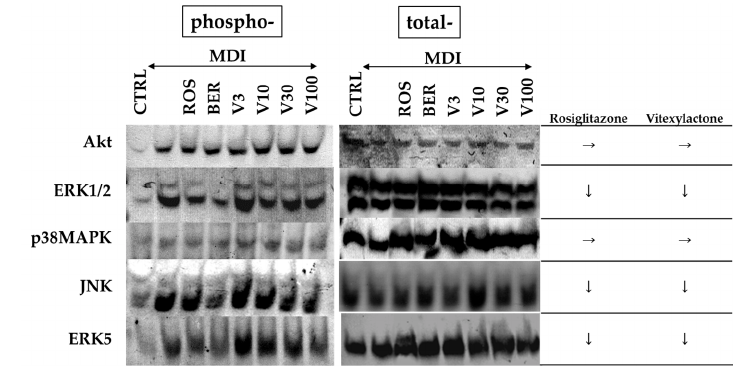
Figure 6. The effects of each compound on the phosphorylation of signal transduction-related kinases in 3T3-L1 cells 30 min after the addition of each compound. Protein levels were measured by electroblotting. Undifferentiated cells, cells with the addition of MDI (a mixture of 0.5 mM 3-isobutyl-1-methylxanthine (M), 0.1 μ M dexamethasone (D), and 2 μ M insulin (I)), rosiglitazone, berberine, and vitexilactone are indicated by CTRL, MDI, ROS, BER, and V, respectively. → and ↓ represent no change or down-regulation, respectively.